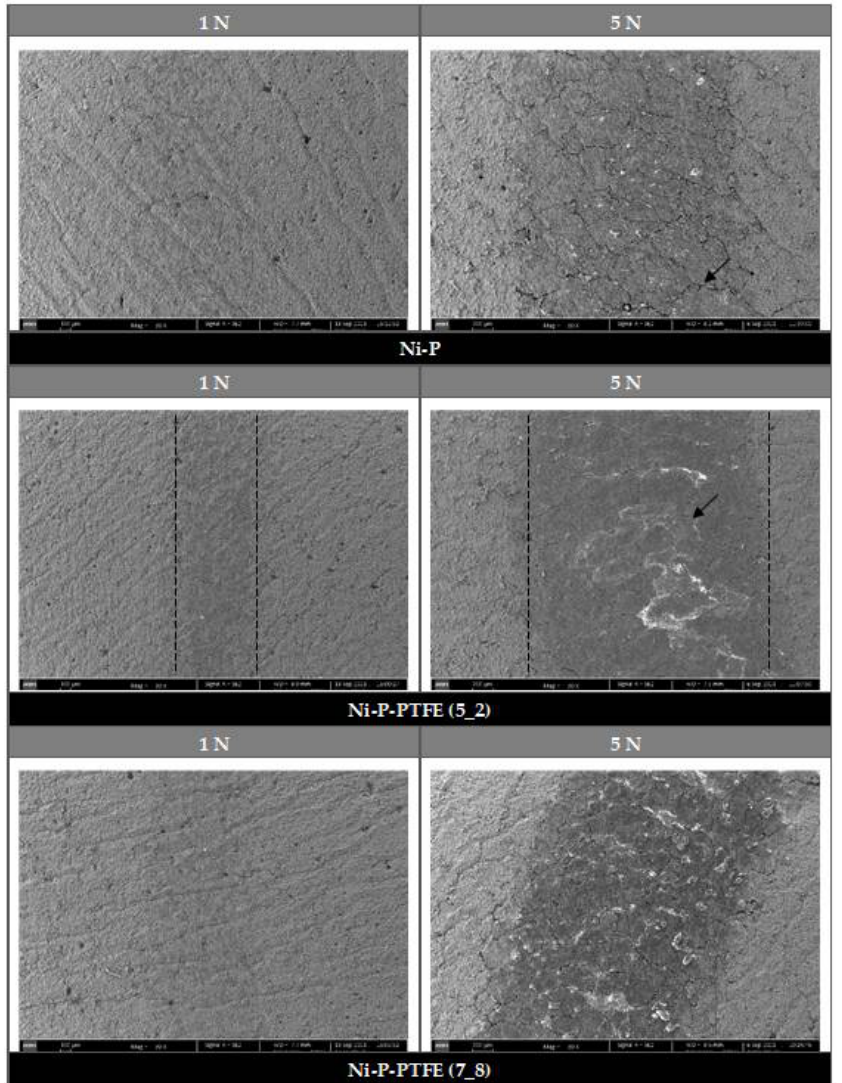
Figure 6. SEM micrographs of wear tracks of Ni-P and Ni-P-PTFE films on rPDA-NBR at 30× magnification. Arrows indicate cracks.